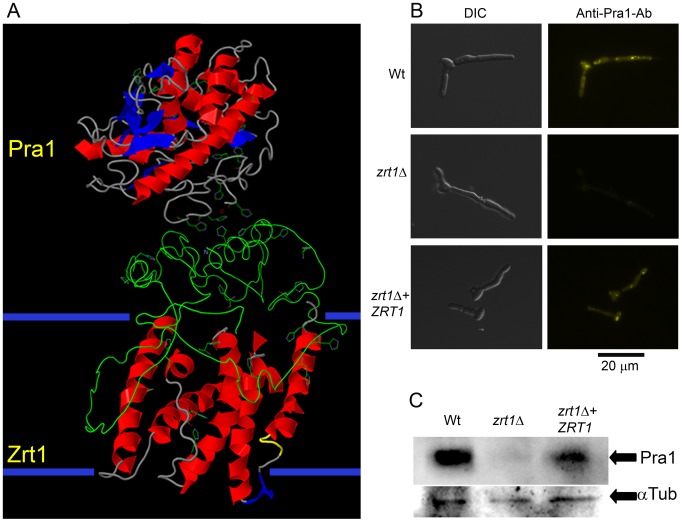
Zrt1 is required for reassociation of soluble Pra1 to the fungal cell.(A) Predicted three-dimensional structures and interaction of Pra1 and Zrt1. The large extracellular domain of Zrt1 represents the N-terminal tail from amino acids 1–183. (B) C. albicans wild type (M1477), zrt1Δ (M2006) and zrt1Δ+ZRT1 (M2010) were exposed to recombinant His-tagged Pra1 and binding visualised with a fluorescently conjugated anti-His antibody (experiment was performed twice in triplicate); (C) additionally, binding of rPra1 was assessed by Western Blot hybridisation (experiment was performed twice). Note that deletion of ZRT1 precludes reassociation of Pra1 with the fungal cell.